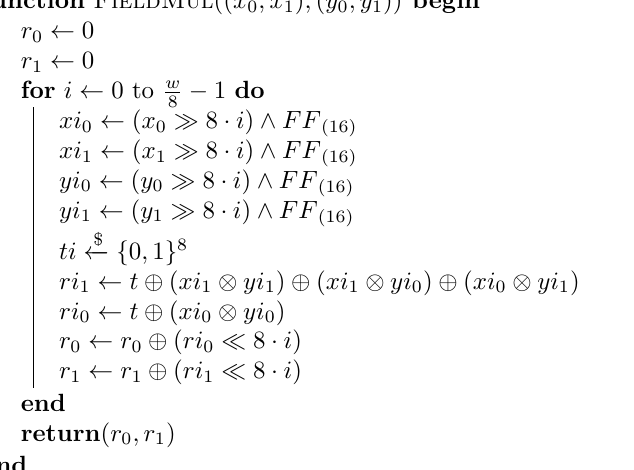
Algorithm 21: FieldMul : apply packed F masking).